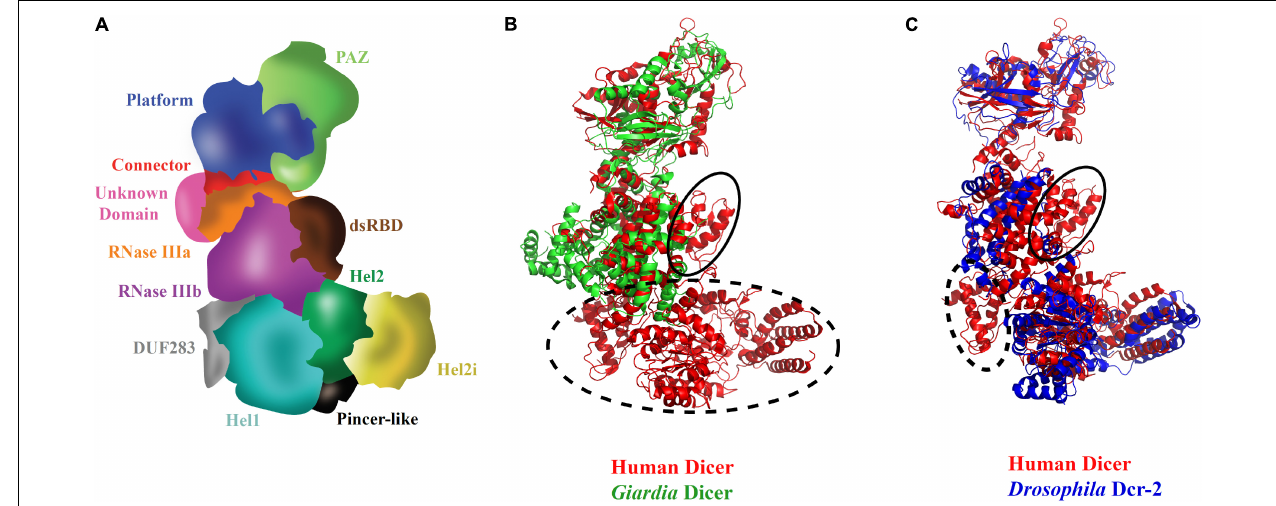
FIGURE 3 | Three-dimensional view of Dicer and its domains. (A) Scheme of Hs Dcr domain arrangements prepared based on the cryo-EM structure (Liu et al., 2018). The unique structural arrangement of domains makes it possible for processing several kinds of dsRNA substrates. (B) Overlay of Hs Dcr (PDB code: 5ZAK) and Gi Dcr (PDB code: 2QVW). The PAZ and RNase III domains in Gi Dcr are necessary and sufficient for dsRNA cleavage. However, Hs Dcr possesses an additional helicase domain which is important in recognition of different terminal loop lengths of pre-miRNAs for efficient cleavage. The dashed circle in the overlay shows the absence of DUF283 and helicase domains in Gi Dcr and the solid circle indicates the absence of the dsRBD domain in Gi Dcr. (C) Overlay of cryo-EM structures of Hs Dcr (PDB code: 5ZAK) and Dm Dcr-2 (PDB code: 6BUA) indicates overall conservation of domains in the three-dimensional space in diverse eukaryotes. The helicase subdomain Hel1 (DExD/H-box domain) which is important for ATP hydrolysis is conserved in both Hs Dcr and Dm Dcr-2. However, the Hs Dcr helicase domain functions in an ATP-independent manner, whereas the ATP hydrolysis by Dm Dcr-2 Hel1 domain allows it to recognize blunt-end dsRNA for viral defense. The dashed circle in the overlay shows the absence of cryo-EM density for DUF283 in Dm Dcr-2 and the solid circle shows the absence of cryo-EM density for the dsRBD domain in Dm Dcr-2, indicating their dynamic nature in comparison with the Hs Dcr. The PDB files were superimposed and the images were created using